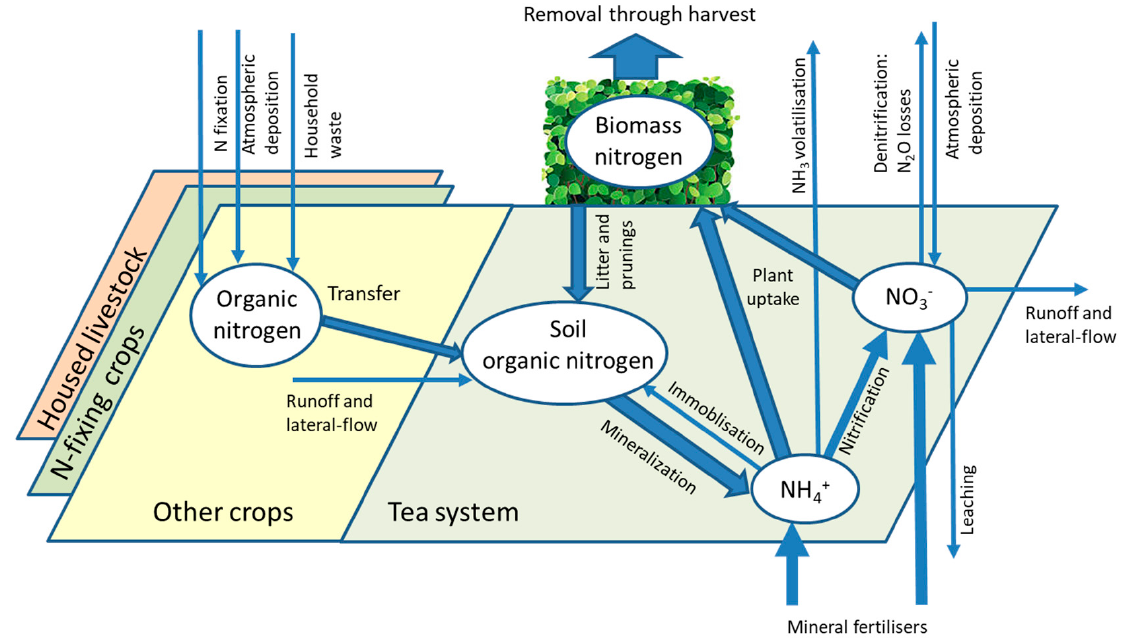
Figure 2. Nitrogen flows in tea plantations, focusing on organic management. Inorganic fertiliser additions could also be used to increase the size of the NO 3 − and NH 4+ pools.